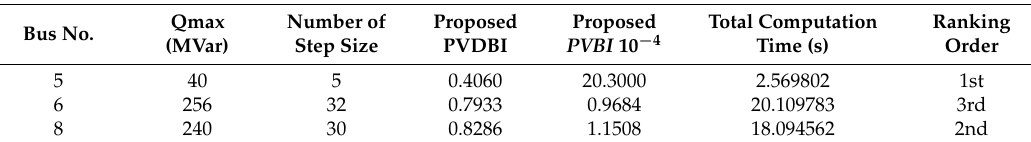
Table 1. Results of the traditional voltage collapse proximity index ( VCPI ) for the 9-bus system.